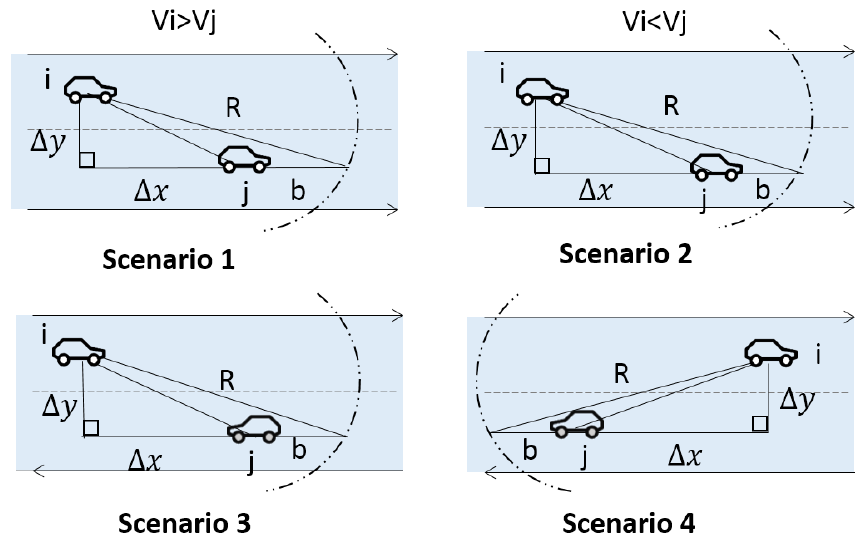
Figure 5. Link stability